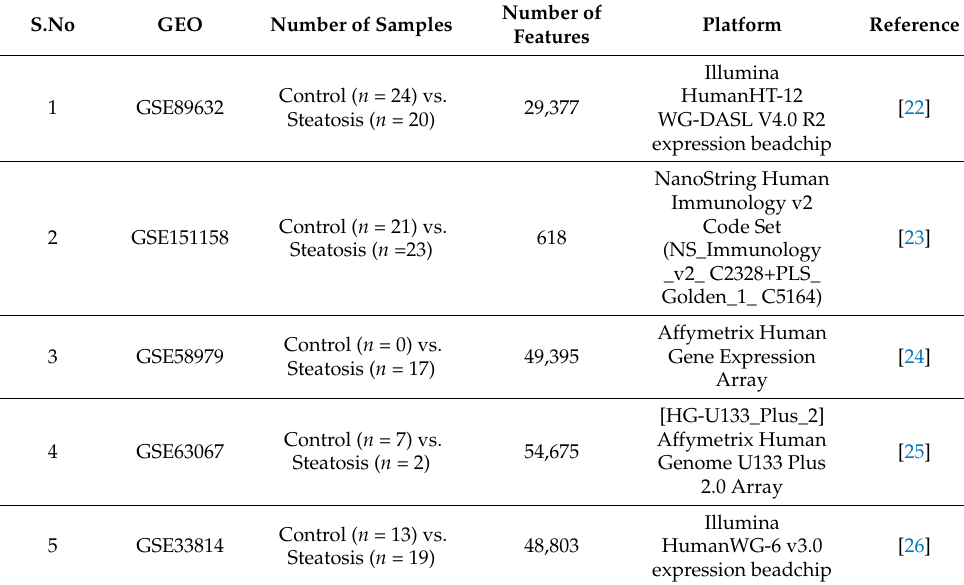
Table 1. Details of the transcriptomics data used in the